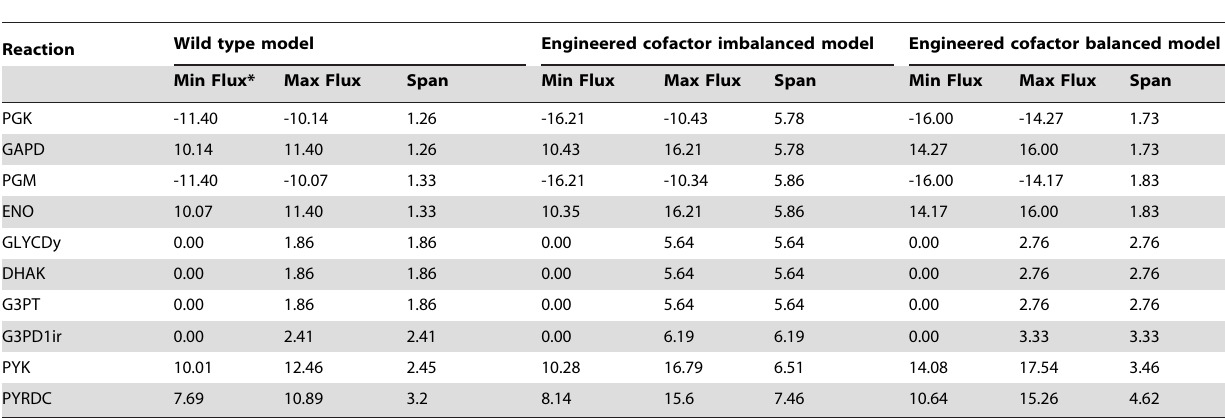
Table 2. The minimum and maximum allowable flux values for each reaction in the wild type, engineered cofactor imbalanced, and engineered cofactor balanced models were obtained using Flux Variability Analysis